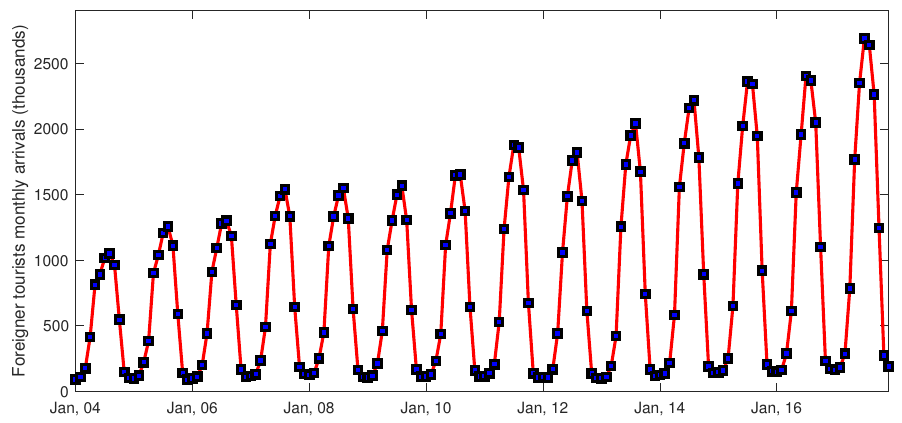
Figure 3. Monthly arrivals of foreign tourist from 2004 to